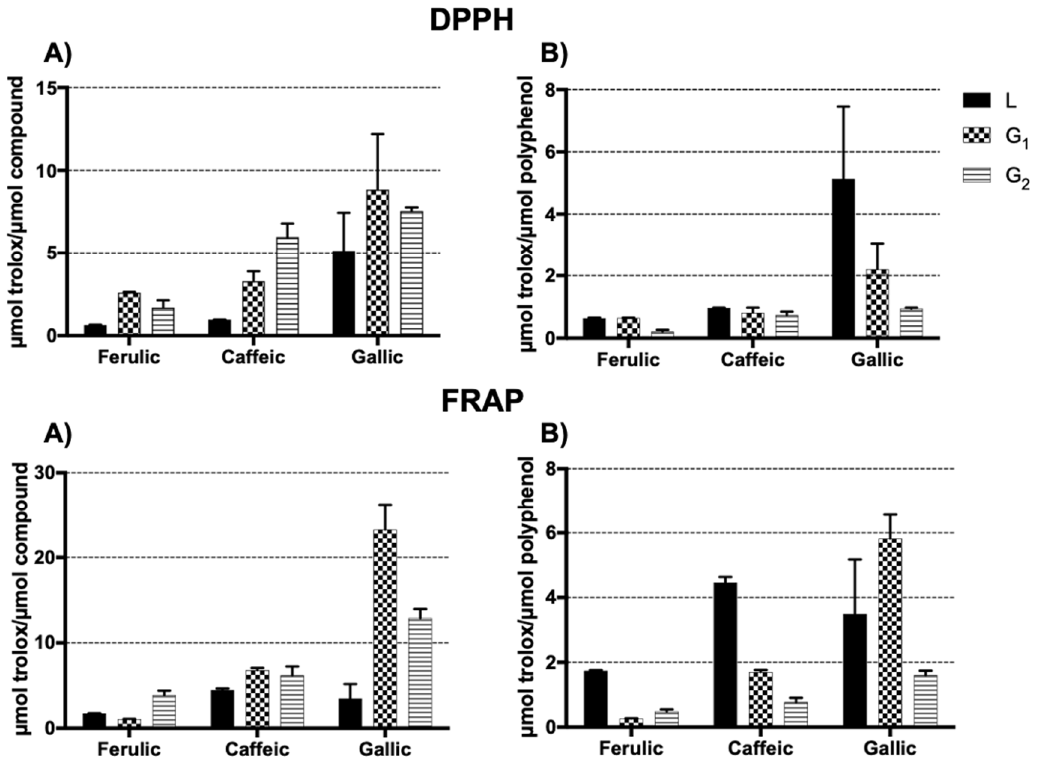
Figure 5. Results of antioxidant activity of compound 1 ‒ 6 , expressed in Trolox units for DPPH and FRAP assays: ( A ) micromole of Trolox per micromole of the compound; or ( B ) micromole of polyphenol. Mean values ± SEM, representative of at least three independent experiments, are shown.